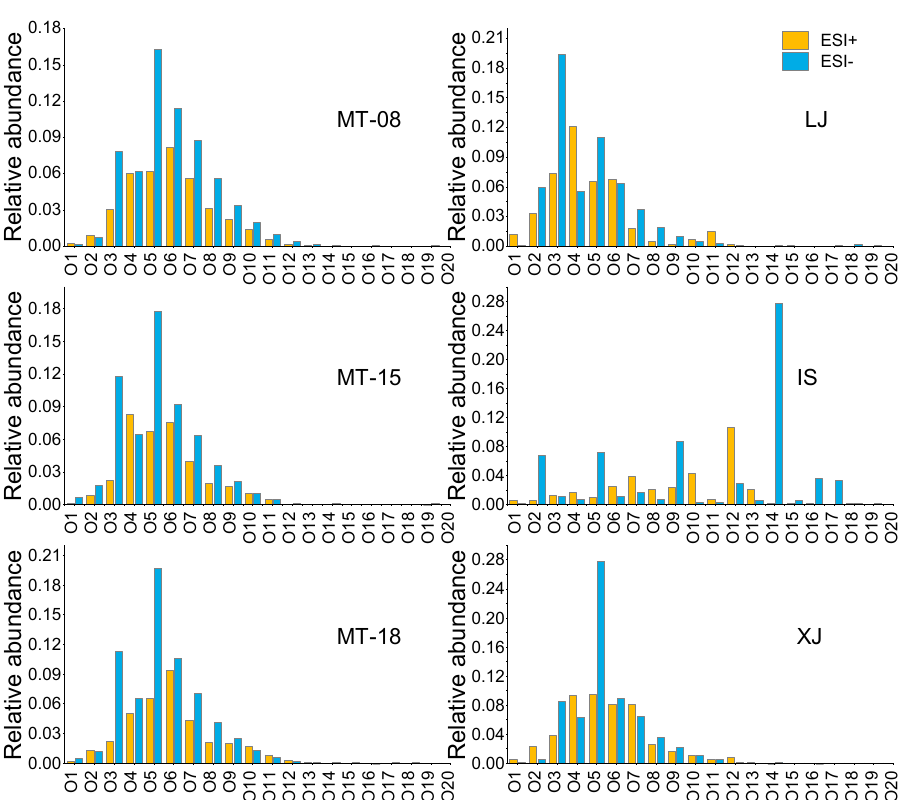
Figure 3. Relative abundance of Ox class compounds detected by ESI+ and ESI − in different sauce- flavor Baijiu. Yellow represents the results measured by ESI+ mode and blue represents the results measured by ESI − mode.